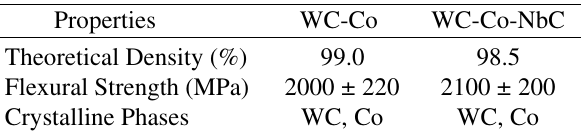
Table 1. Mechanical properties and crystalline phases of WC-Co- NbC sintered specimens.